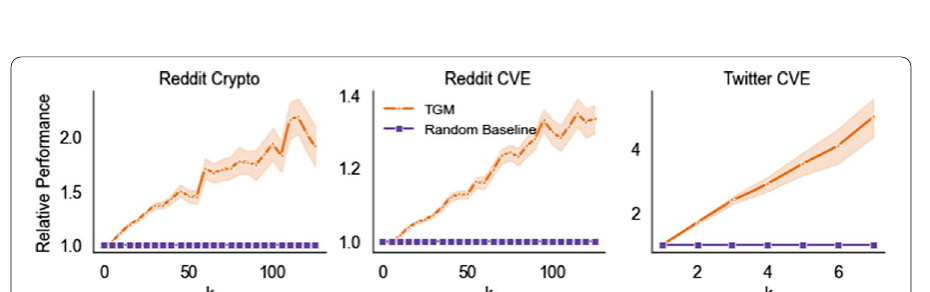
Fig. 7 Probability of placing the next node correctly, normalized by the random baseline model. Reddit Crypto and Reddit CVE results are binned over k (bin width (cid:31) k = 5 ) to improve readability and reduce